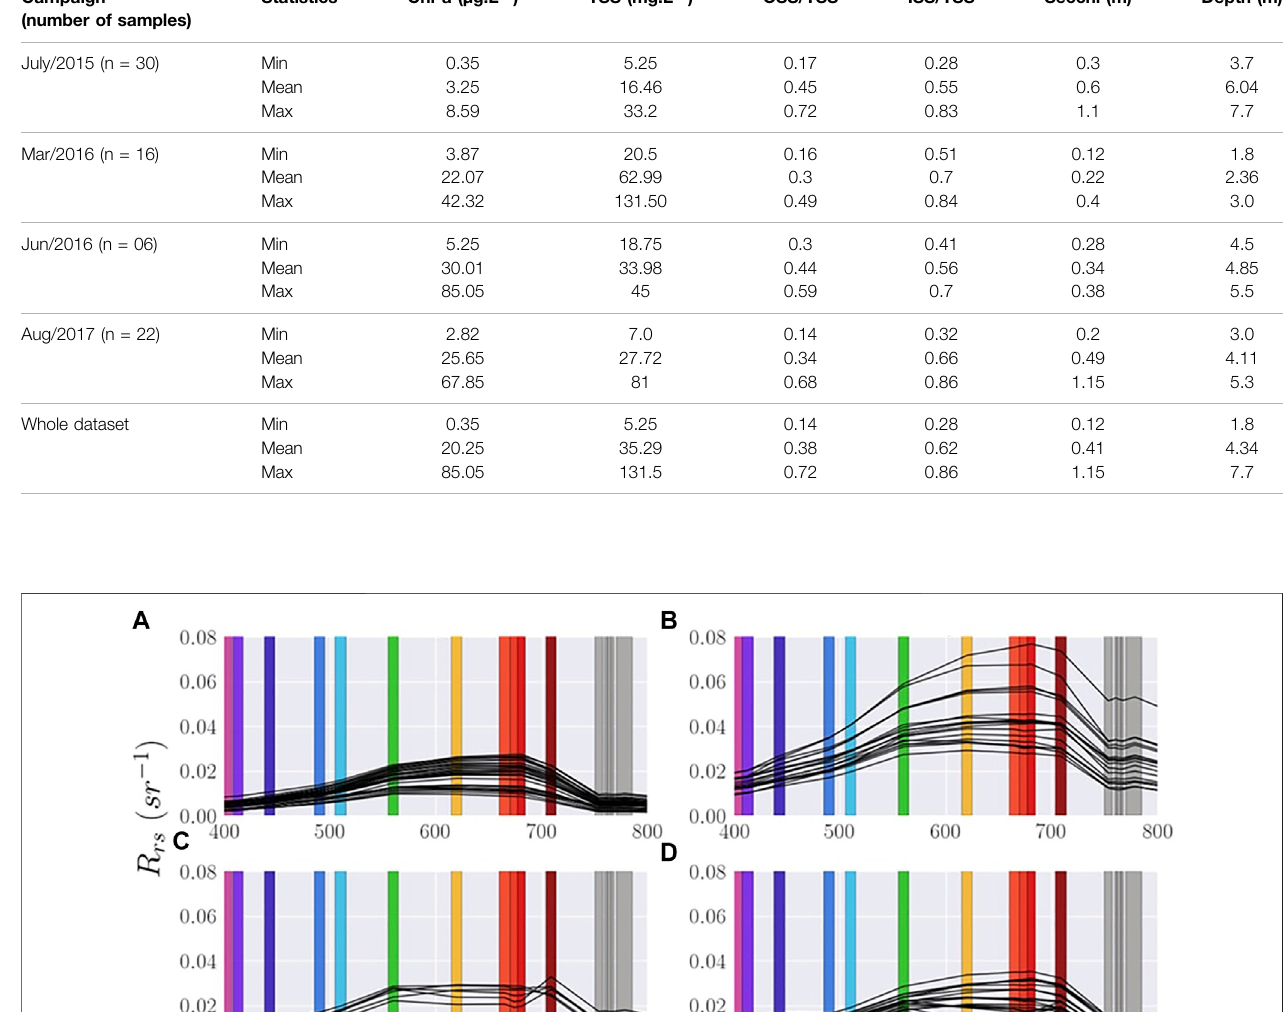
Frontiers in Remote Sensing |